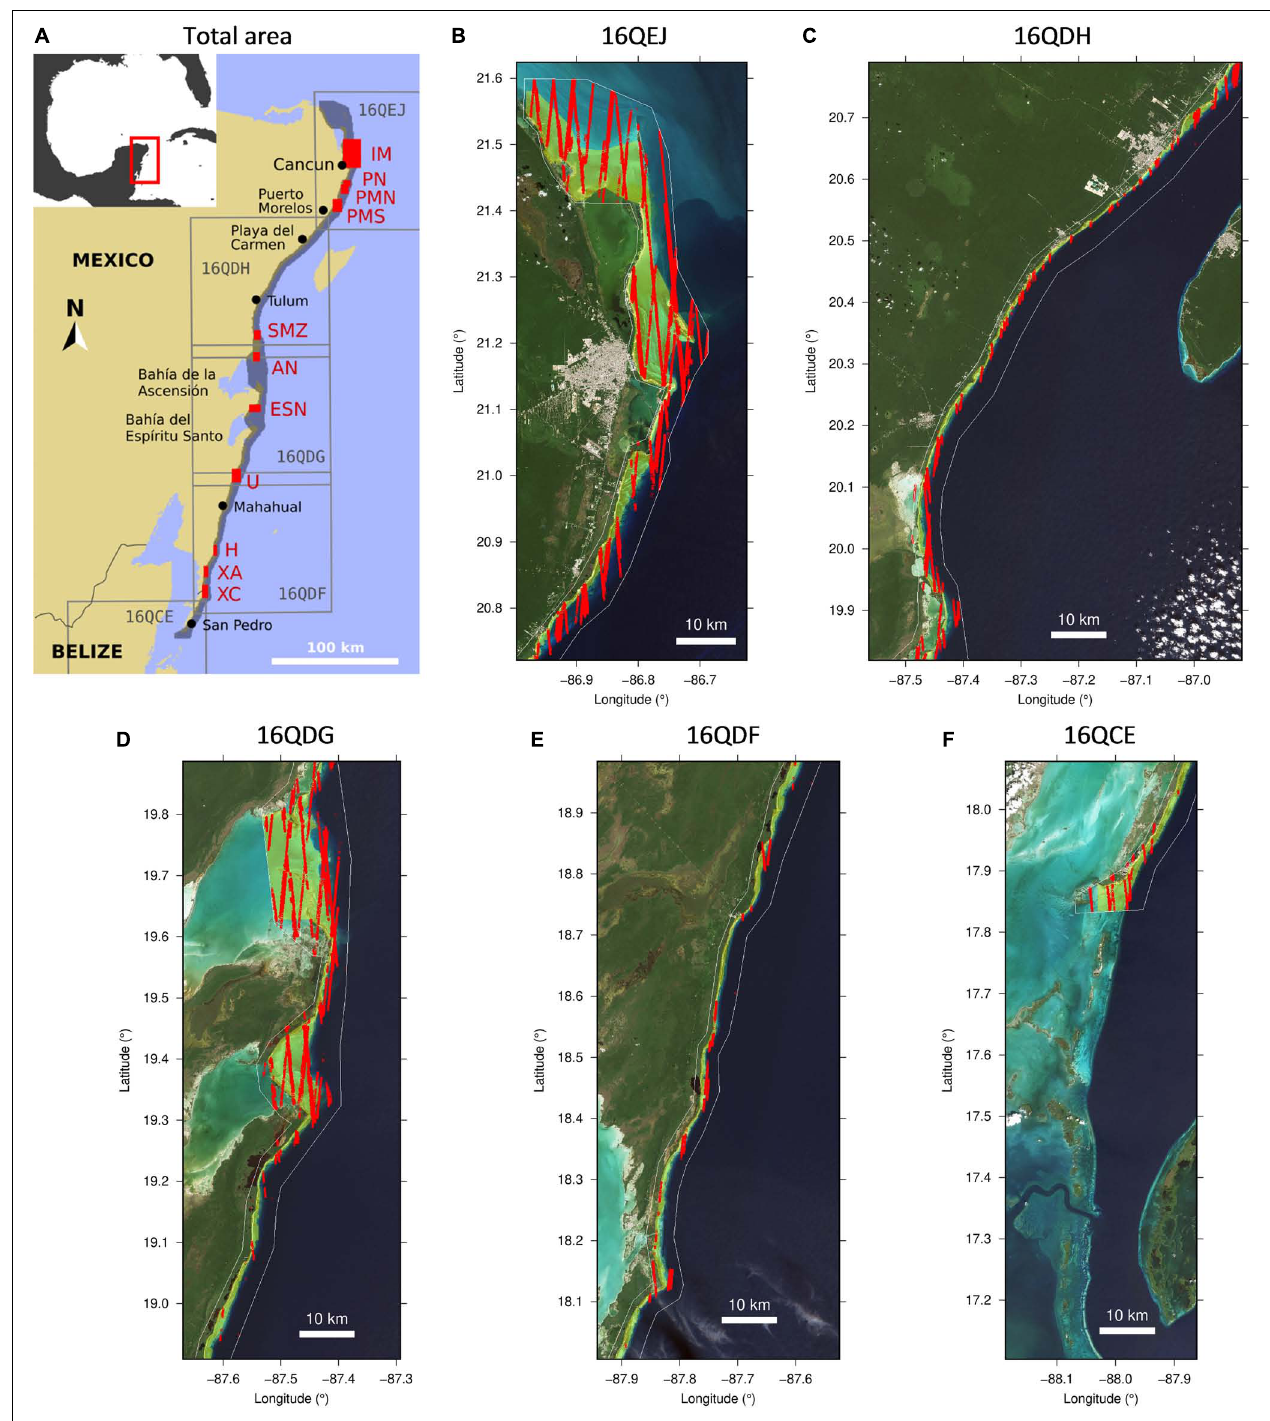
FIGURE 1 | (A) Processed area spanning five Sentinel-2 tiles is shaded dark, sites of interest are shown in red ( Table 1 ). (B–F) Relevant section of each tile. White line delimits the processed area. Filled yellow region is the manually delimited lagoon area. Red lines are the ICESat-2 data after screening and delimiting to the processed area, a total of 46069 points. (B–E) RGB background images are Sentinel-2 bands B04, B03, and B02 for 13 December 2017 for and (F) 24 September